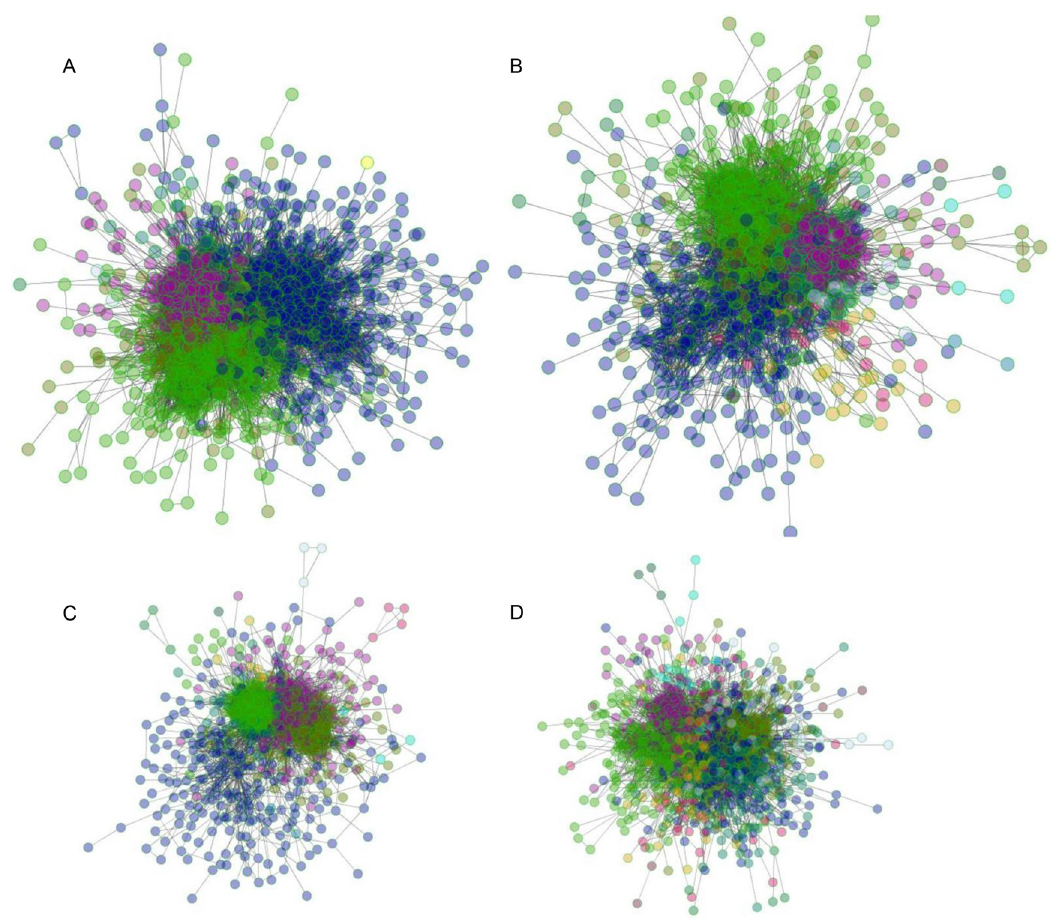
Fig 3. Construction of PPI and module networks in CRC subtypes. Nodes of a module forming subnetworks of PPI were colored differently on a subtype basis (same color across different subtypes didn’t represent similar groupings of module function). The images of CMS1(A), CMS2(B), CMS3(C), CMS4(D) were shown